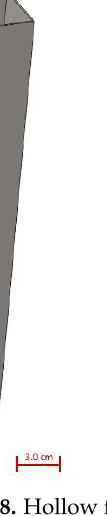
Figure 8. Hollow furrower of the onion transplanter.